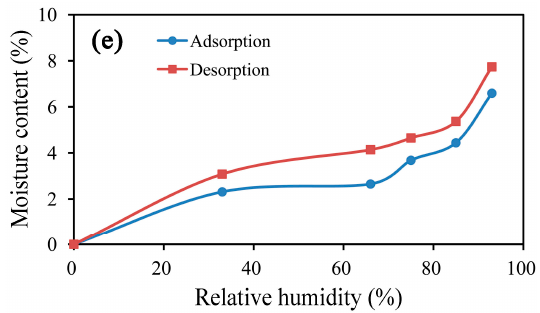
Figure 4. Comparative analysis of the adsorption and desorption behavior of the prepared composites containing different mass percentages of mRPC: ( a ) 0% mRPC; ( b ) 3% mRPC; ( c ) 5% mRPC; ( d ) 7% mRPC; ( e ) 10% mRPC.